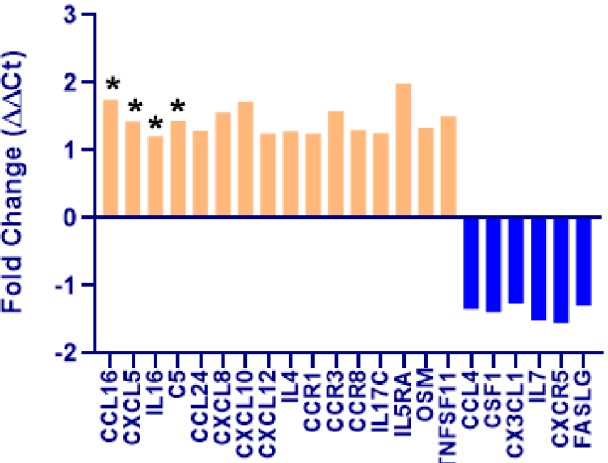
Figure 3. Graphical representation of selected genes that were up-regulated (orange) or down-regulated (blue) in dogs with chronic kidney disease (CKD; n = 10) when compared to controls ( n = 10). There was a significant up-regulation in CCL16, CXCL5, IL-16, and C5 in CKD dogs